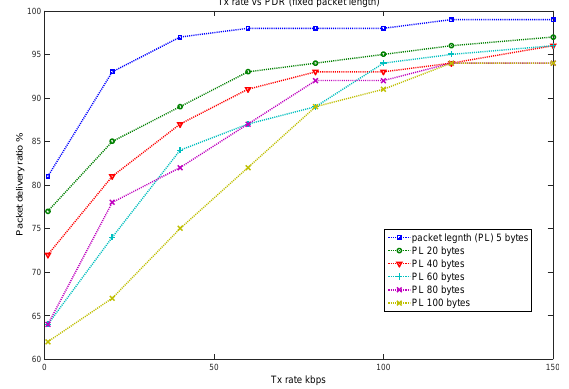
Figure 10: Tx Rate vs Packet delivery ratio evalu- ated with fixed packet length. Measured in CM2 Using the CM 2 model, as the packet length increases, the packet delivery ratio is decreased even for higher data rates